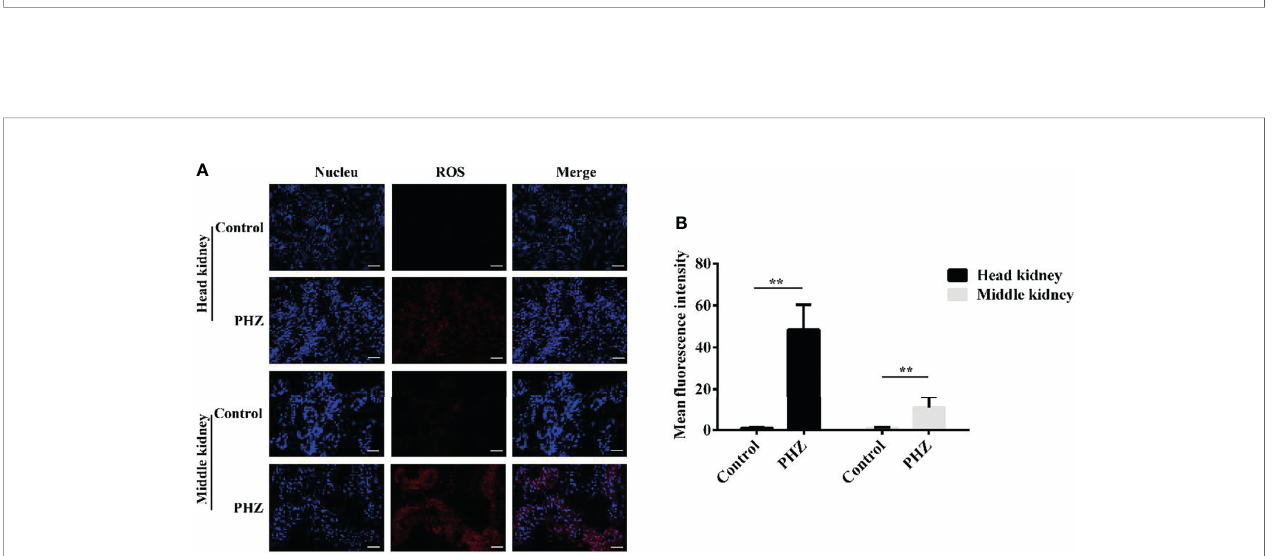
FIGURE 4 | Hemolysis increased the levels of reactive oxygen species (ROS) in the head and middle kidney. (A) TUNEL-stained head and middle kidney at 48 h after phenylhydrazine (PHZ)-induced hemolysis. Scale bar , 40 m m. (B) Mean fl uorescence intensity in different groups at 48 h after PHZ-induced hemolysis. ** p < 0.01 (Student ’ s t -test). Data represent the mean ± SD of three independent experiments.